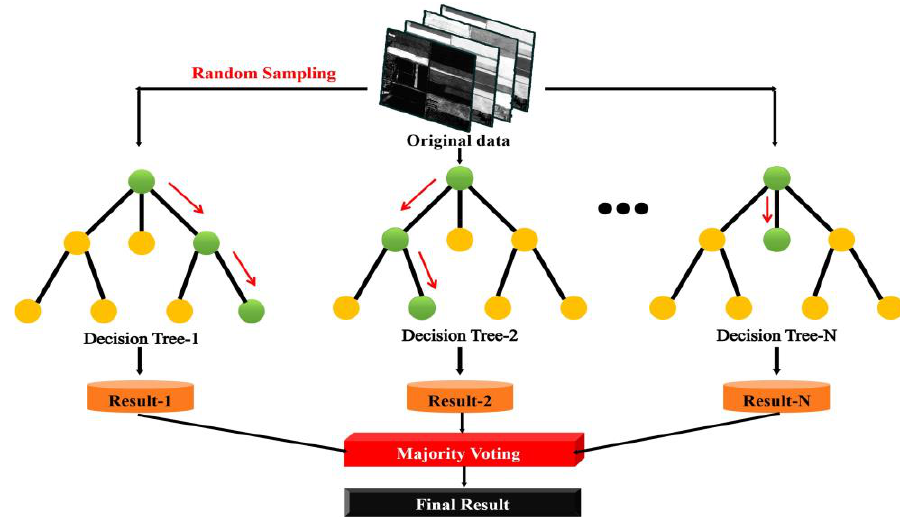
Figure 8. Classification process of random forest algorithm.